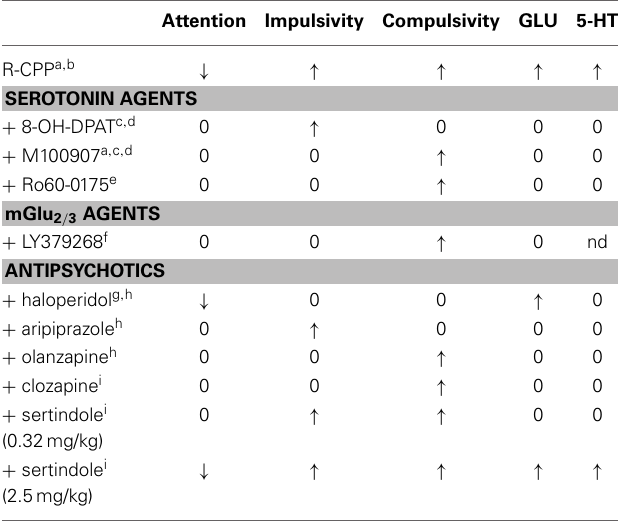
Table 3 | Summary of the effects of intra-mPFC R-CPP in combinations with 5-HT 1A , 5-HT 2A , and 5-HT 2C agents, an mGlu 2 / 3 agonist and various antipsychotics on attention and executive control and glutamate (GLU) and serotonin (5-HT) release in the